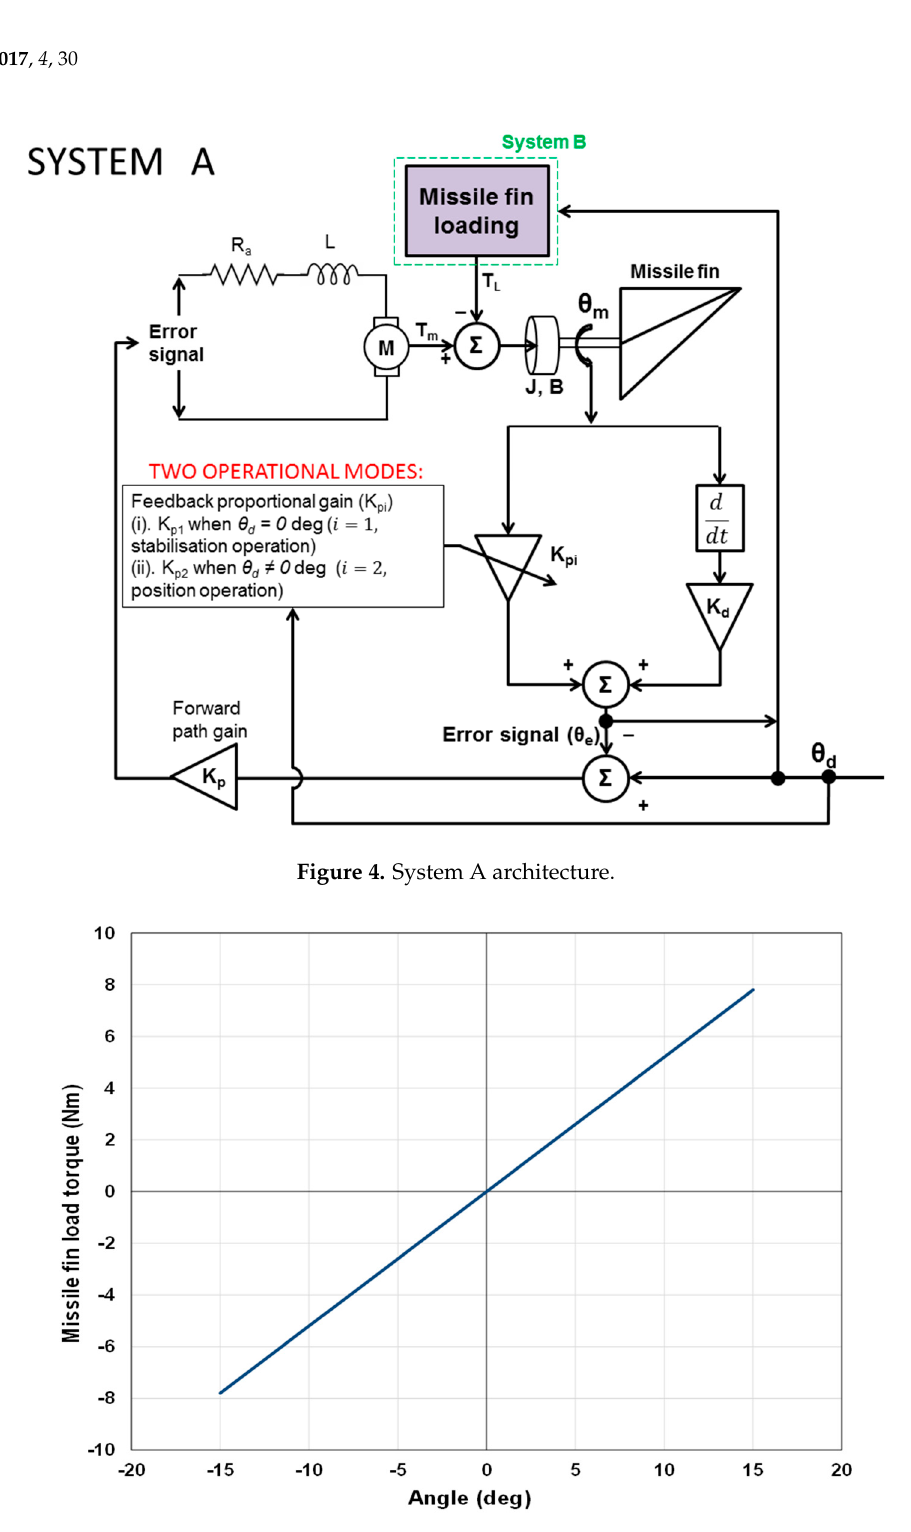
Figure 5. Missile fin load torque characteristics.